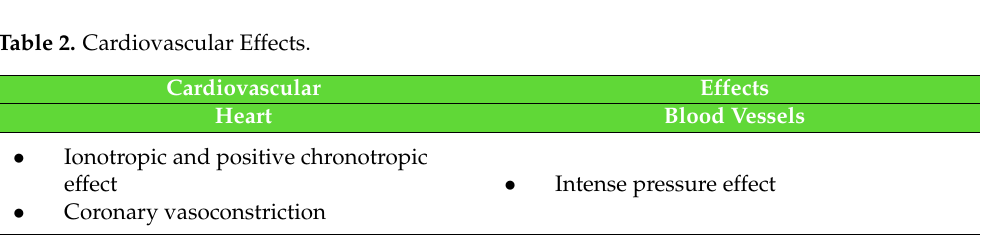
Table 3. Effects on Smooth Muscles.